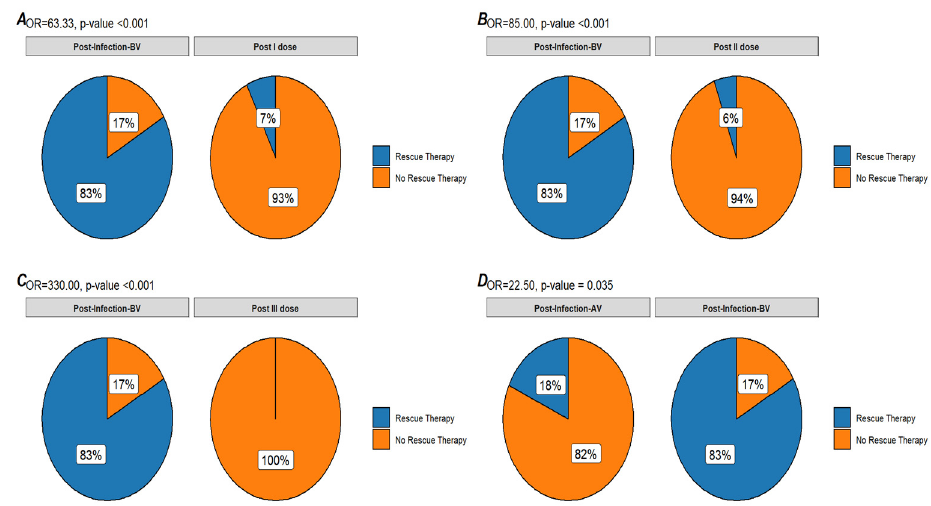
Figure 3. Round plot of rescue therapy necessity . Comparison in terms of rescue therapy necessity between infection before vaccination (Post-Infection-BV), Post first vaccine dose (Post I dose) ( A ), second dose (Post II dose) ( B ), and third dose (Post III dose) ( C ) and post-infection after vaccination (Post-Infection-AV) ( D ).